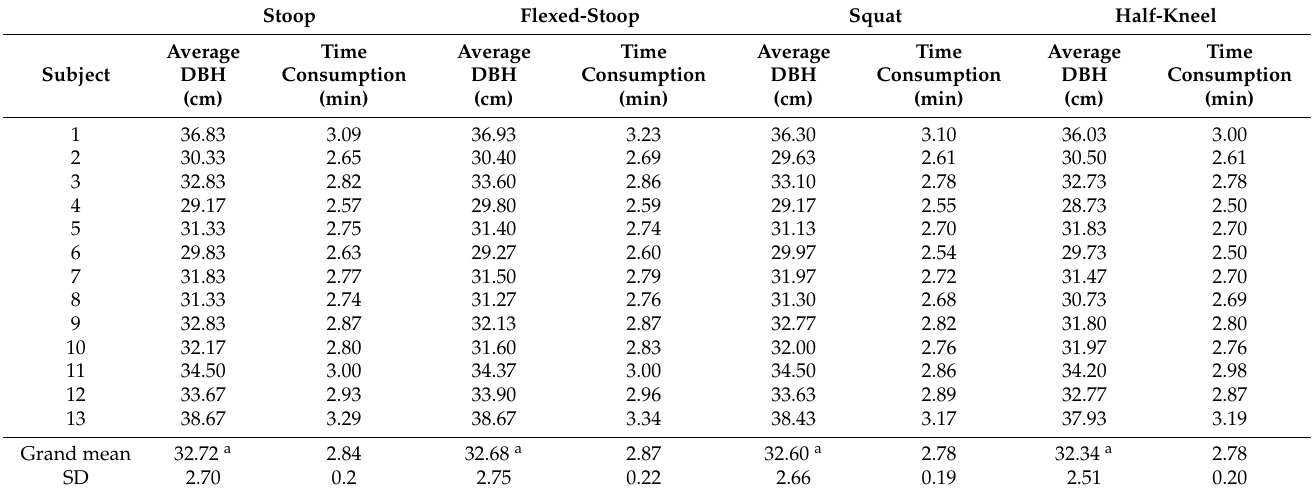
Table 4. Average diameter at breast height (DBH) of the 30 felled trees per body posture and average tree felling time consumption per subject and